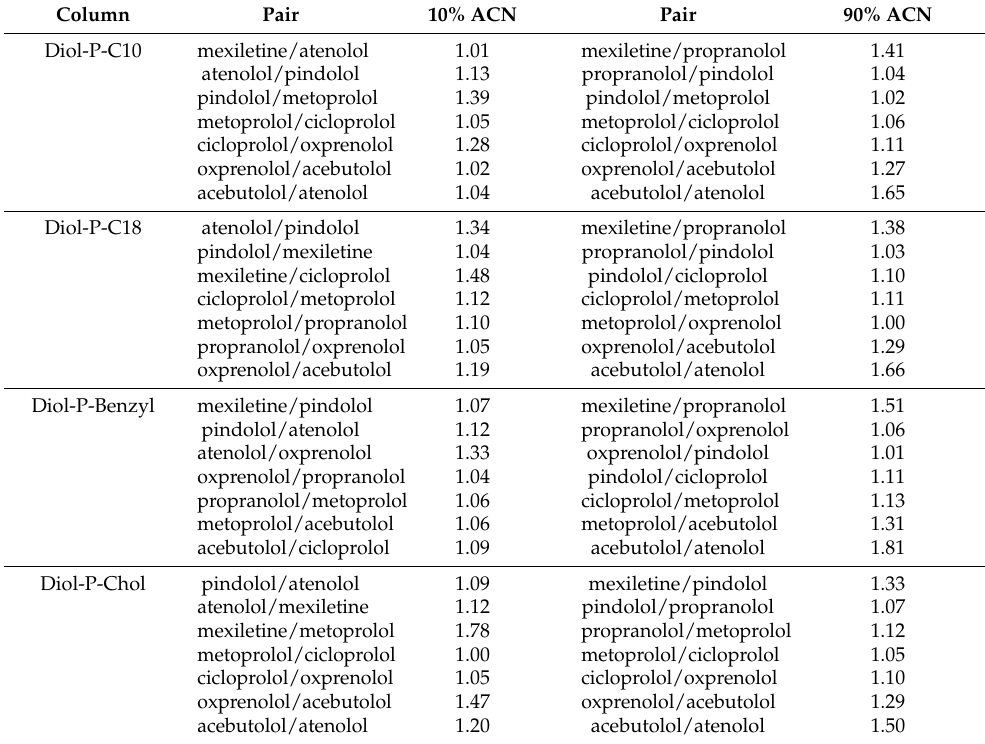
Table 3. Selectivity in RP (10% ACN) and HILIC (90% ACN).